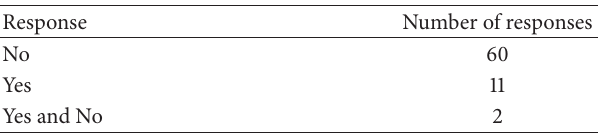
Table 3: Responses to the question “do you usually use a bolus when treating the chest wall in patients with breast cancer who have had immediate reconstructive